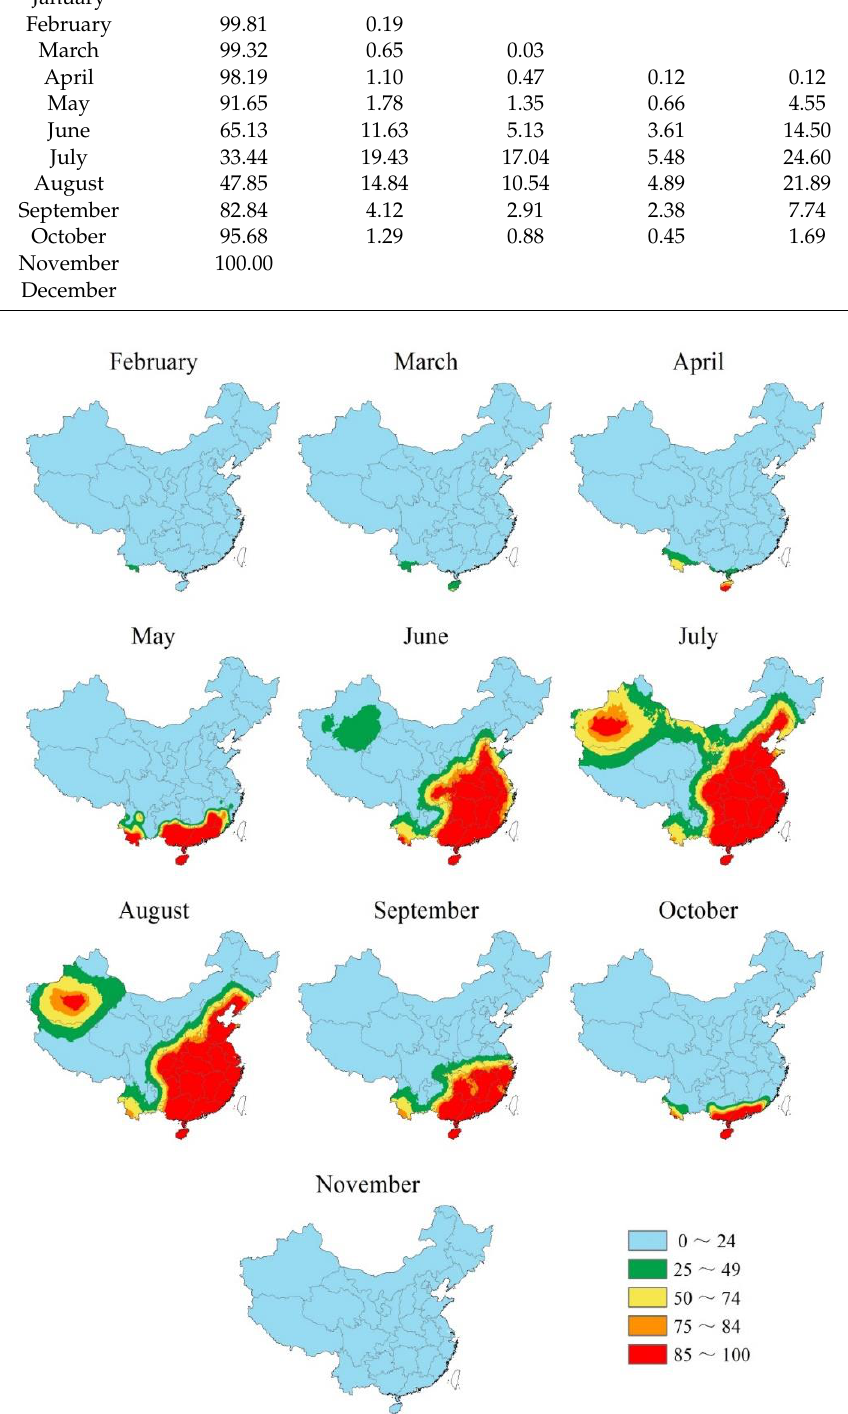
Figure 4. Indicator kriging maps produced using THI 79 for February to November.